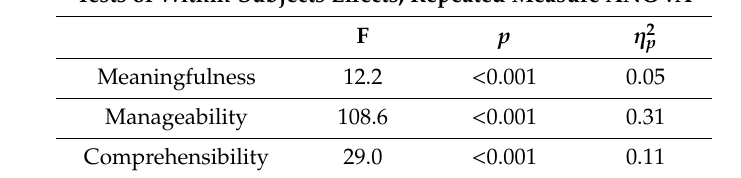
Table 1. Repeated measure ANOVA comparing meaningfulness, manageability and comprehensibility between baseline, 3 months, and 9 months after relocation to activity-based workplaces ( n = 246).